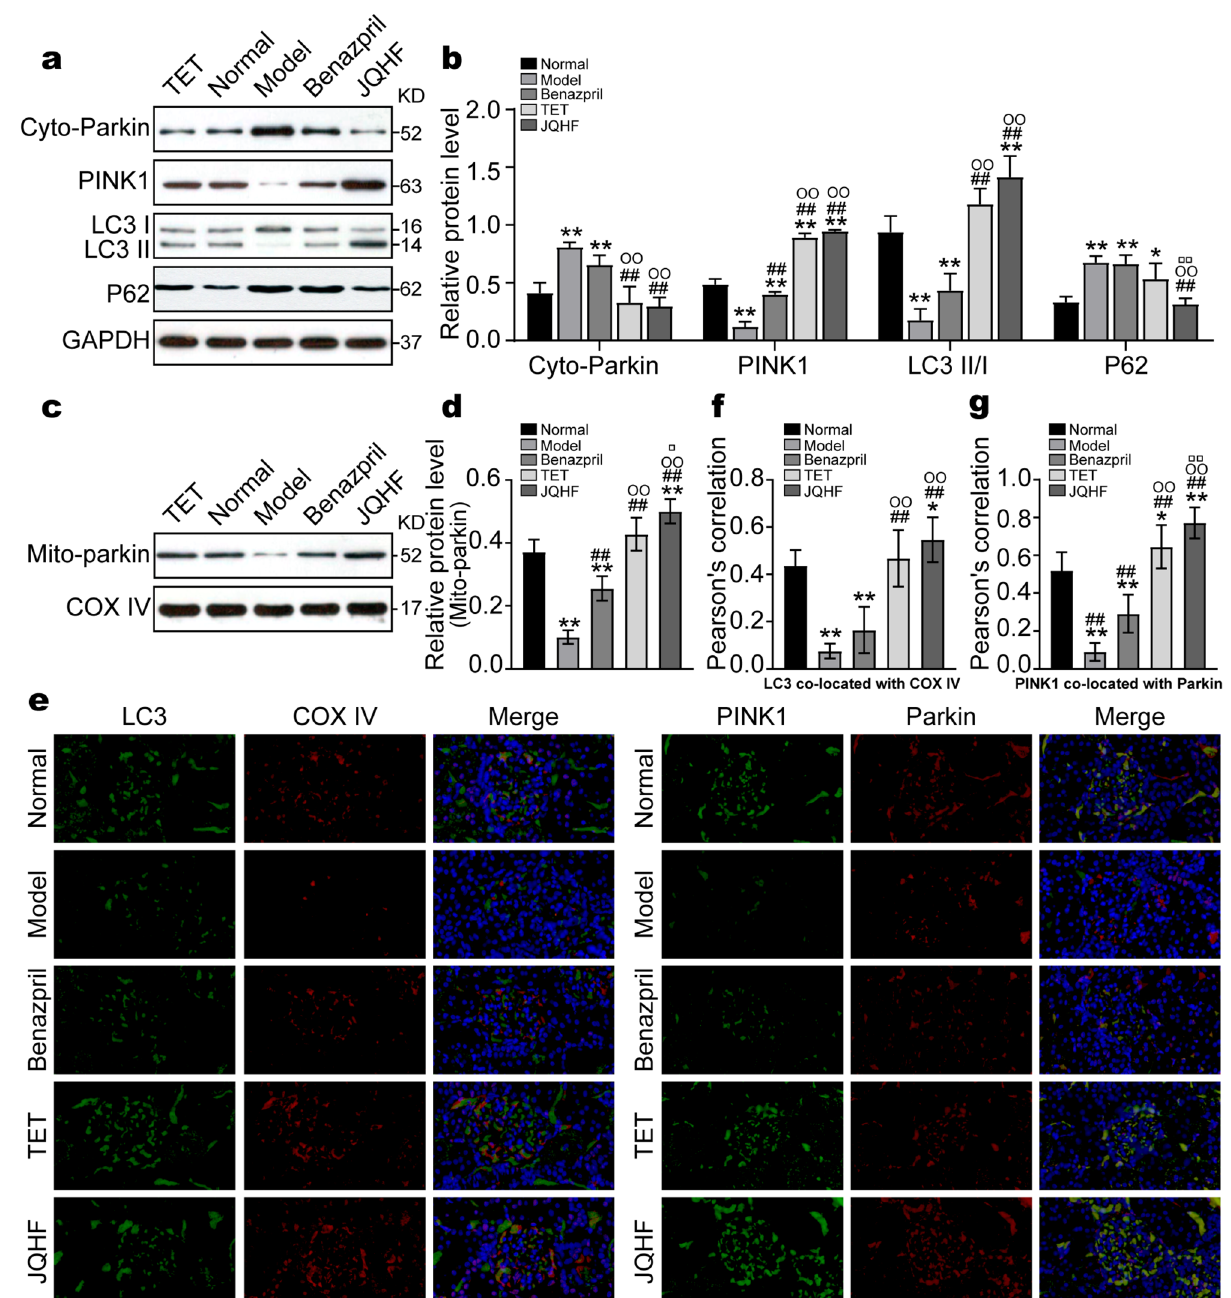
Figure 3. Effects of JQHF on PINK1/Parkin pathway in the kidneys of PHN rats. ( a , c ) Western blot analysis of Cyto-parkin, PINK1, LC3, P62 and Mito-Parkin protein expression in each group. Full-length blots are presented in Supplementary Fig. 1 and Supplementary Fig. 4. ( b , d ) Quantitative analysis of Cyto-parkin, PINK1, LC3-II/I, P62 and Mito-Parkin protein expression. ( e ) Representative images (×400) of immunofluorescence that LC3 co-localization with COX IV, and PINK1 co-localization with Parkin. COX IV was used as a mitochondrial tracker. LC3 or PINK1 was labeled by fluorescein isothiocyanate (FITC) (green), COX IV or Parkin was labeled by tetramethylrhodamine isothiocyanate (TRITC) (red), and nuclei were stained with DAPI (blue). Strong colocalization signals were seen as yellow dots after merging. ( f , g ) Quantitative analysis of the amount of co-localization presented by Pearson’s correlation. Data were analysed by one-way ANOVA followed by post hoc LSD test ( b , d , f , g ) and presented as the mean ± SD (n = 6). *P < 0.05 vs. Normal group, **P < 0.01 vs. Normal group, ## P < 0.01 vs. Model group, ○○ P < 0.01 vs. Benazepril group, □ P < 0.05 vs. TET group, and □□ P < 0.01 vs. TET